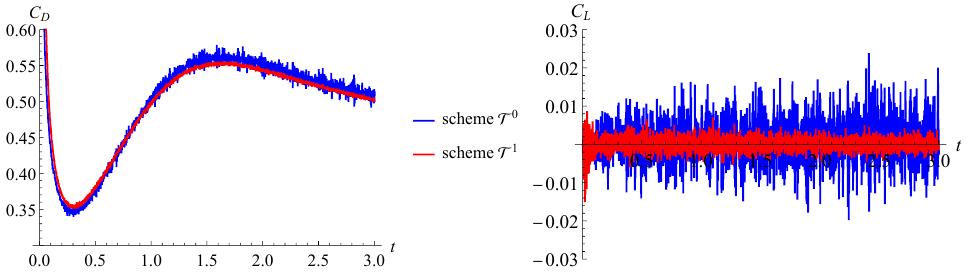
Figure 8. Hydrodynamic load oscillations for flow simulation around impulsively starting cylinder: the schemes T 0 and T 1 ; Re = 200.